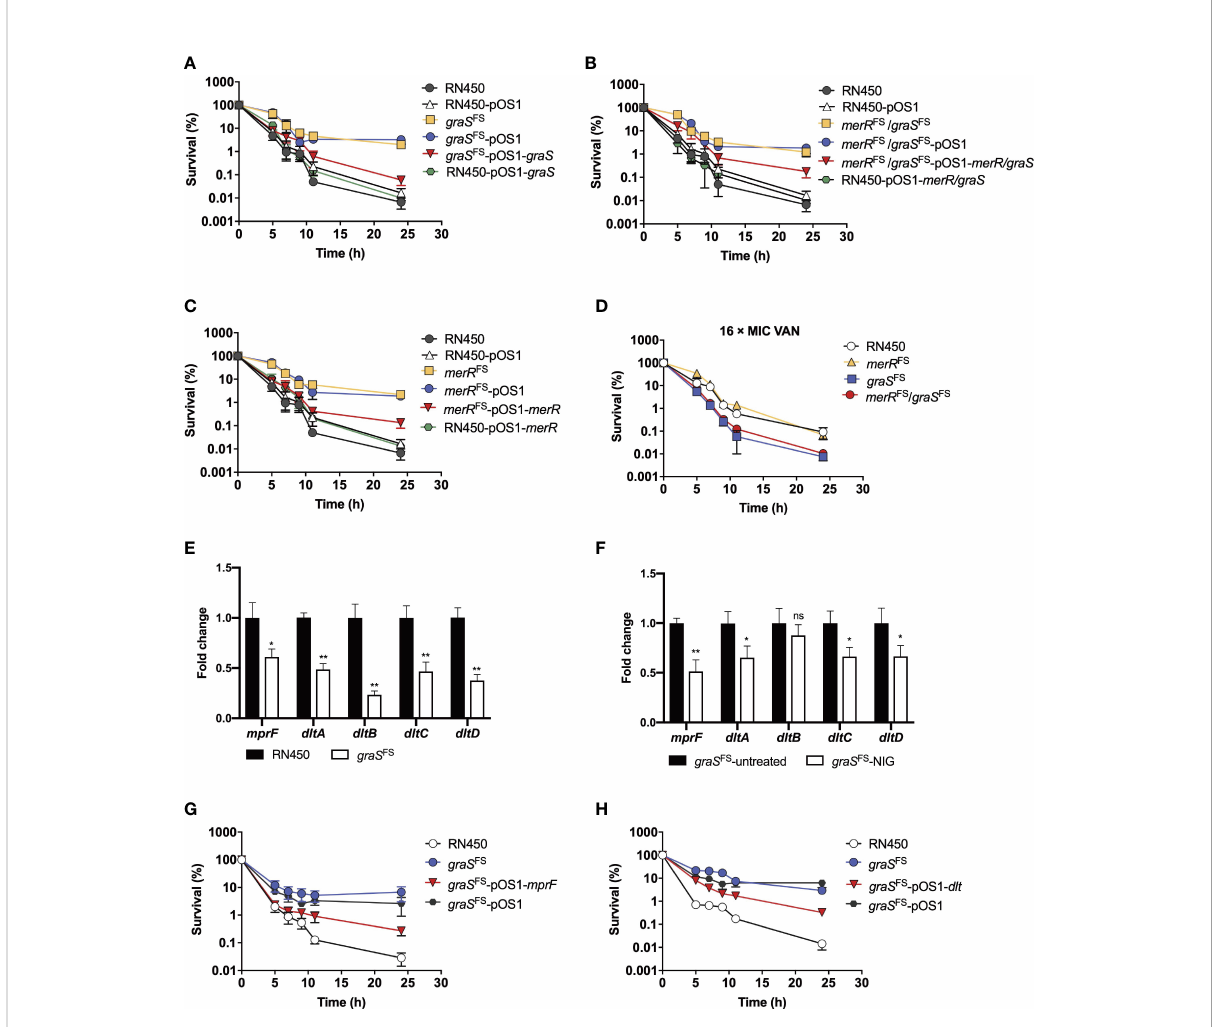
FIGURE 6 Involvement of the GraSR two-component regulatory system in reduced nigericin activity against of S. aureus . (A – C) Viability of S. aureus RN450 strains having de fi ciencies plus or minus complementary expression of graS, merR , or both upon treatment with nigericin (16 × MIC). merR FS = merR with a Thr184 frameshift; graS FS = graS with an Asn147 frameshift. pOS1 is a plasmid vector used for complementary expression of gene in S. aureus . (D) Increased killing by vancomycin (VAN) of S. aureus RN450 graS mutant strains. (E) Change in dlt and mprF mRNA expression levels in graS FS and S. aureus RN450. Levels of each mRNA in graS FS were normalized to those of corresponding mRNA in S. aureus RN450. Data are average of 3 biological replicates; error bars indicate SD. * p < 0.1; ** p < 0.01. (F) Change in dlt and mprF mRNA expression levels in graS FS strain treated or untreated with NIG. The graS FS strain was treated with 2 × MIC nigericin (NIG) for 1 h. mRNA level of each gene was normalized to untreated control. Data are average of 3 biological replicates; error bars indicate SD. ns, not signi fi cant; * p < 0.1; ** p < 0.01. (G) Partial reversal of graS de fi ciency-mediated protection from nigericin killing by ectopic expression of mprF . S. aureus R450 strains were treated with 16 × MIC of nigericin for the indicated times before samples were taken and processed for viability. (H) Partial reversal of graS de fi ciency-mediated protection from nigericin killing by ectopic expression of dlt . S. aureus RN450 strains were treated with 16 × MIC of nigericin for the indicated times before samples were taken and processed for viability. (D, G, H) Gene designations are as in panels A-C . Data in panels (A – D, G, H) are average of 3 biological replicates; error bars indicate